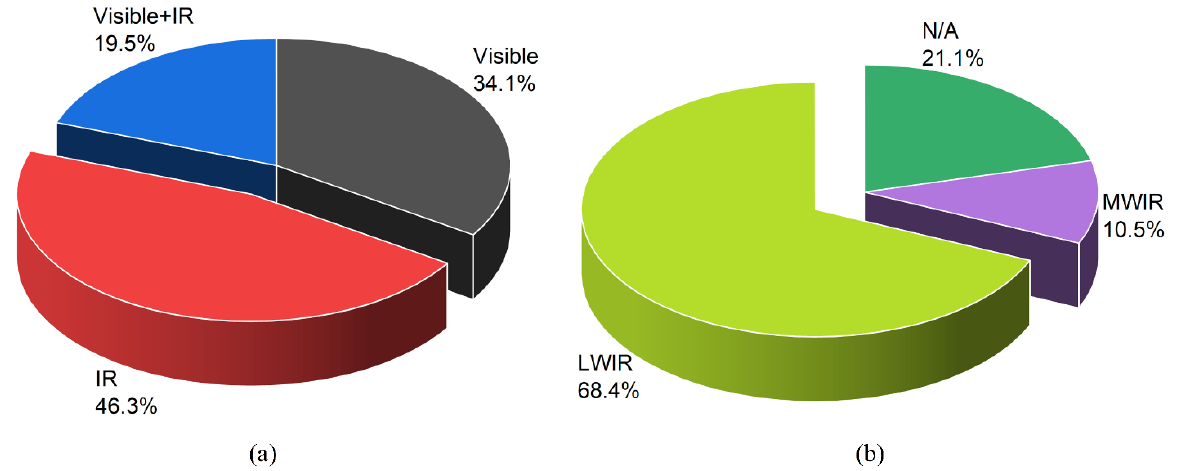
Figure 1. The use of images with different spectra in ship detection: ( a ) The share of the usage of image spectral bands in ship detection. Infrared images were the most commonly used, followed by visible-band images. ( b ) Use of infrared images in different bands; LWIR was used the most.